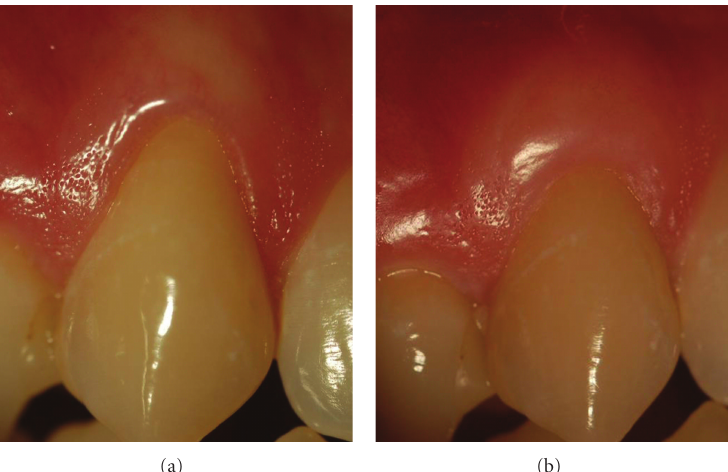
Figure 3: Right maxillary canine (patient #19): (a) before, (b) 3 months after connective tissue graft. The denuded root surface was covered completely. Gingiva is a bit too thick and the color is too